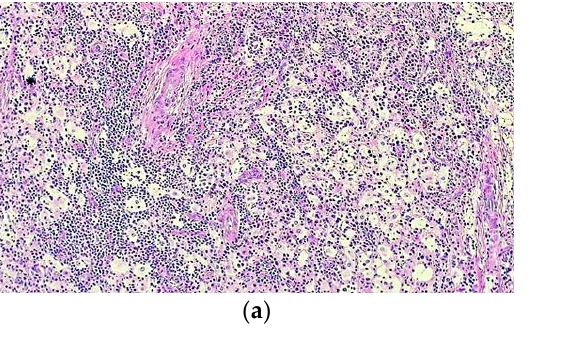
Figure 8. Rosai – Dorfman disease showing ( a ) a prominent histiocytic infiltrate in a background of inflammatory cells, predominantly comprised of lymphocytes and plasma cells (HE staining 40x); ( b ) lesional histiocytes associated with fibrosis and prominent inflammatory infiltrate extended into adjacent bone and soft tissue (HE staining, 40×).